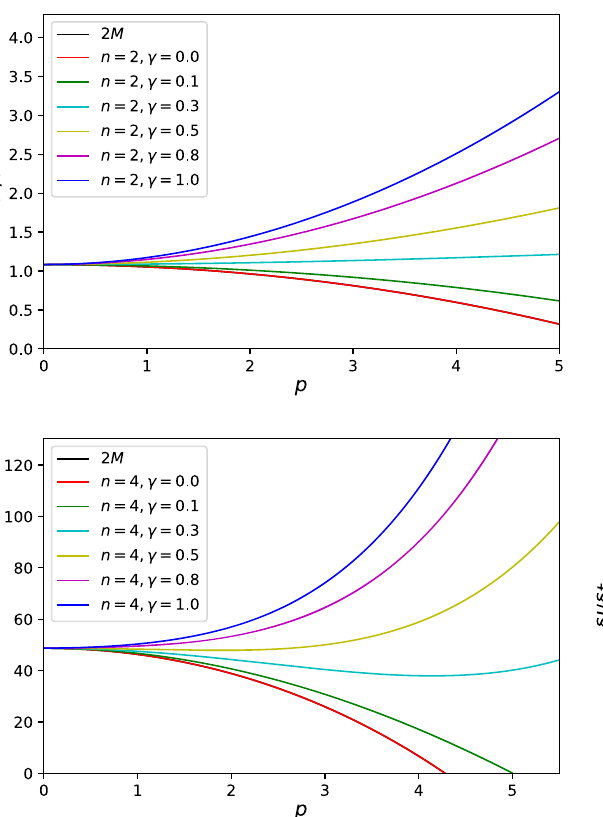
are fixed as β = 0 . 2 , r + = 3 ,(cid:3) = − 1 (upper left plot), β = 0 . 3 , r + = 2 ,(cid:3) = − 1 (upper right plot), β = 1 . 2 , r + = 3 ,(cid:3) = − 1 (lower left plot), β = 0 . 5 , r + = 3 ,(cid:3) = − 1 (lower right